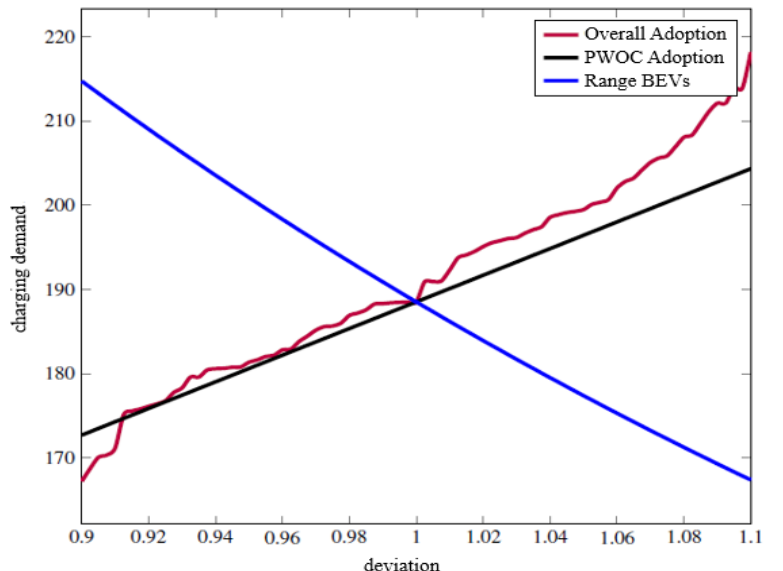
Figure 6. Sensitivity analysis of different influencing factors of public charging demand. The charging demand is measured as the number of private charging events at public charging stations in Munich per